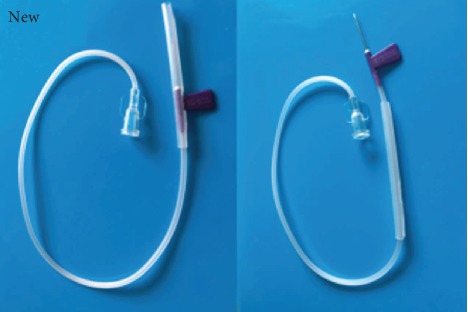
Pictures of the normal infusion set and the new type infusion set.